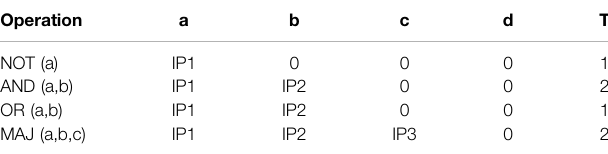
TABLE 2 | Inputsand Threshold selection forvarious bitwiseoperation on asingle AN. IP1, IP2 and IP3 are input operand bits.